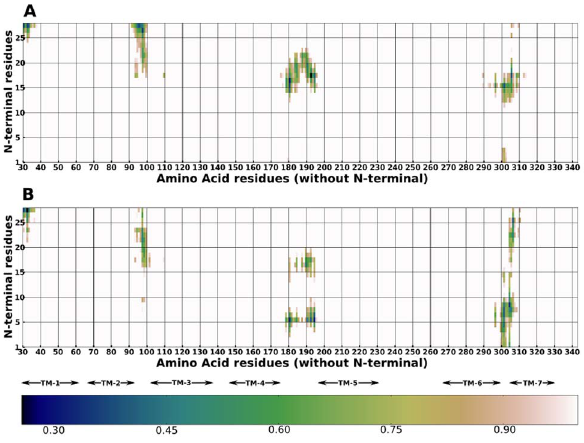
Fig. 5. Contact maps of Arg and Gly variants of b 2 AR. Contacts between the N-terminal region of (A) Arg and (B) Gly variants and the rest of the receptor were computed from the average distance over simulation time. Average distances that were less than or equal to 1 nm were plotted. A color bar is indicated in which white indicates no- contacts and black indicates a close